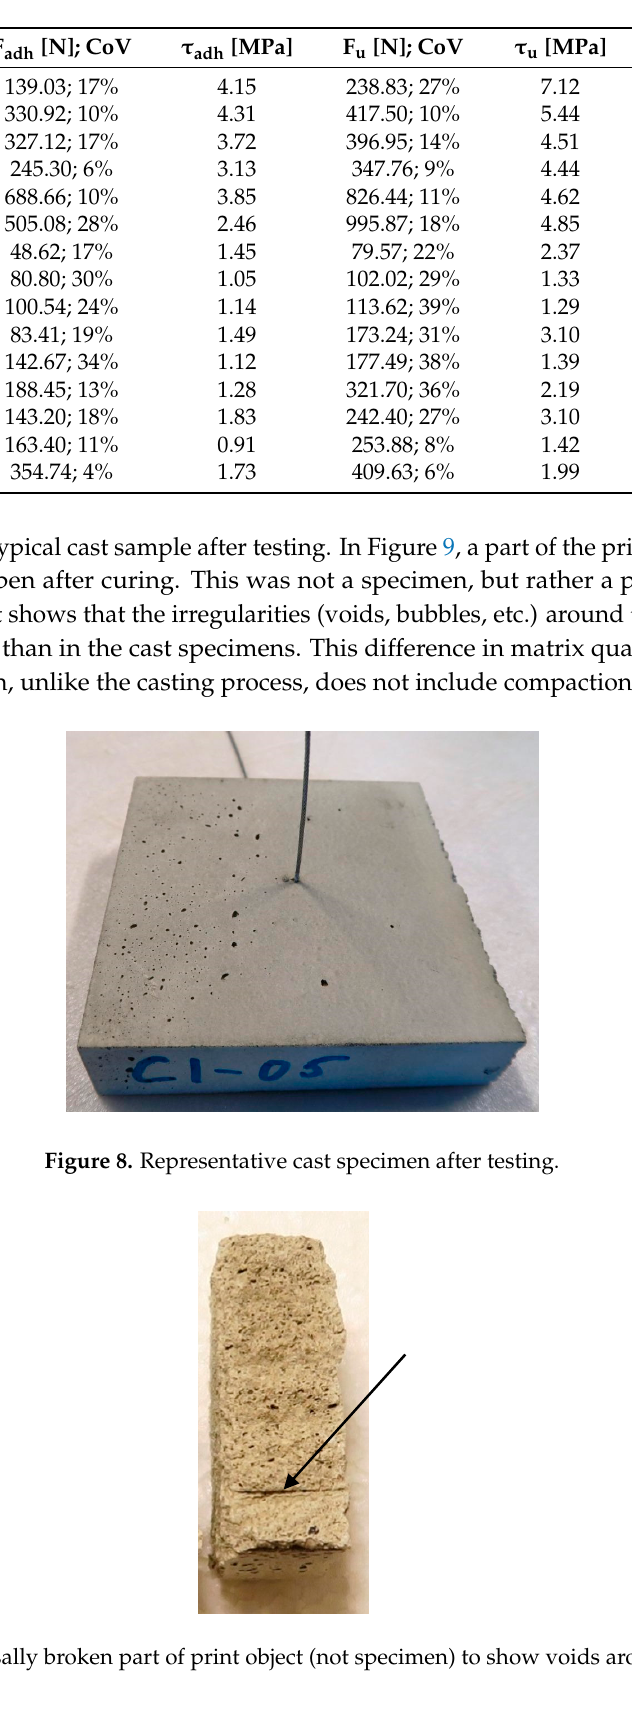
Table 3. Specimen series results.